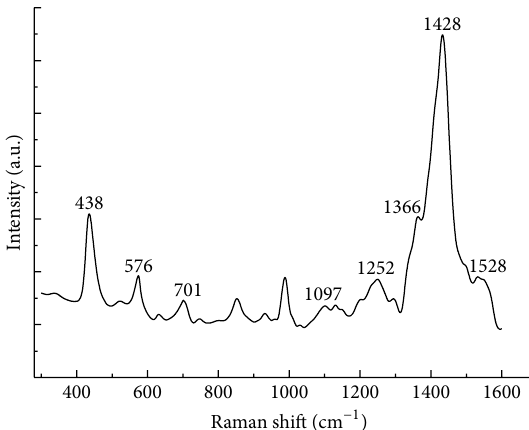
Figure 4: Raman shifts of the electrospun PEDOT:PSS/PVP fibers.